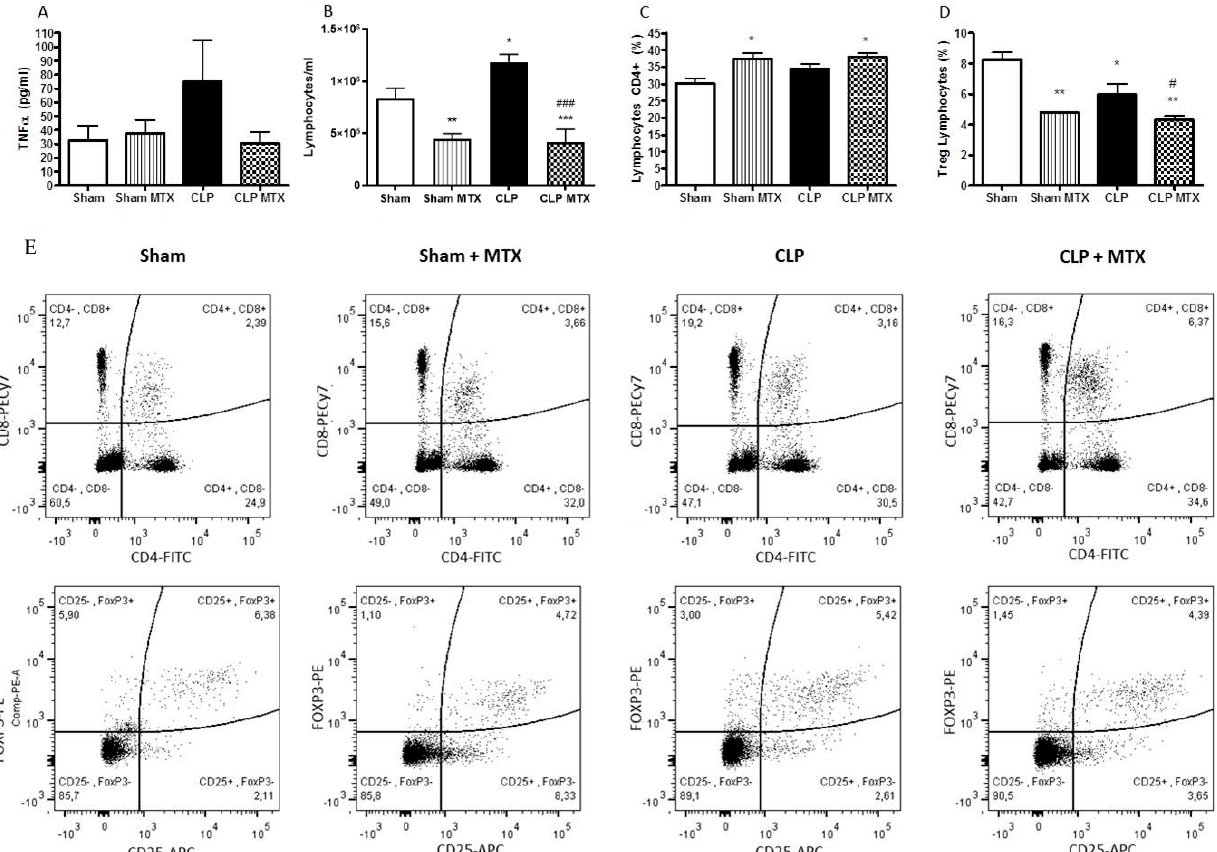
Figure 2. Systemic inflammation and blood lymphocytes activation. ( A ) Concentration of TNF- α in plasma measured by ELISA. ( B ) Number of total lymphocytes from blood cells. ( C ) Percentage of lymphocytes expressing CD4. ( D ) Proportion of CD4+ lymphocytes with a Treg phenotype (CD25+FoxP3+). ( E ) Representative flow cytometry dot plots of all groups. Gattering of CD4+ lymphocytes and Treg phenotype lymphocytes (CD25+FoxP3+). Data is expressed as mean ± SEM. Sham and Sham + MTX n = 4; CLP and CLP + MTX n = 6. * p < 0.05 vs. Sham group; # p < 0.05 vs. CLP group. ** p < 0.01. ***/### p <